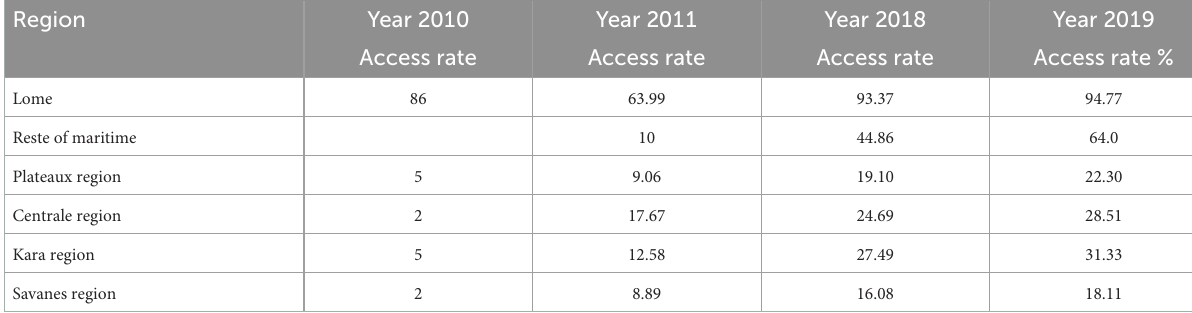
TABLE 7 Breakdown by region of the electrification